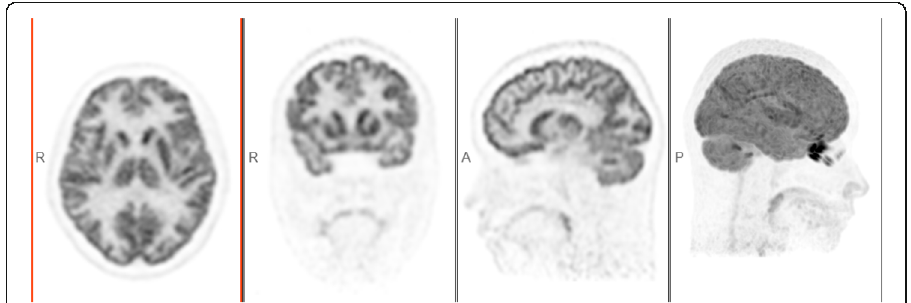
Fig. 5 The brain image of first patient scan (from left to right): transaxial, coronal, sagittal, and MIP (maximum intensity projection). a MIP. b Lesion #1, diameter of 4.4 mm, SUVmax = 3.1. c Lesion #2, diameter of 5.1 mm SUVmax =